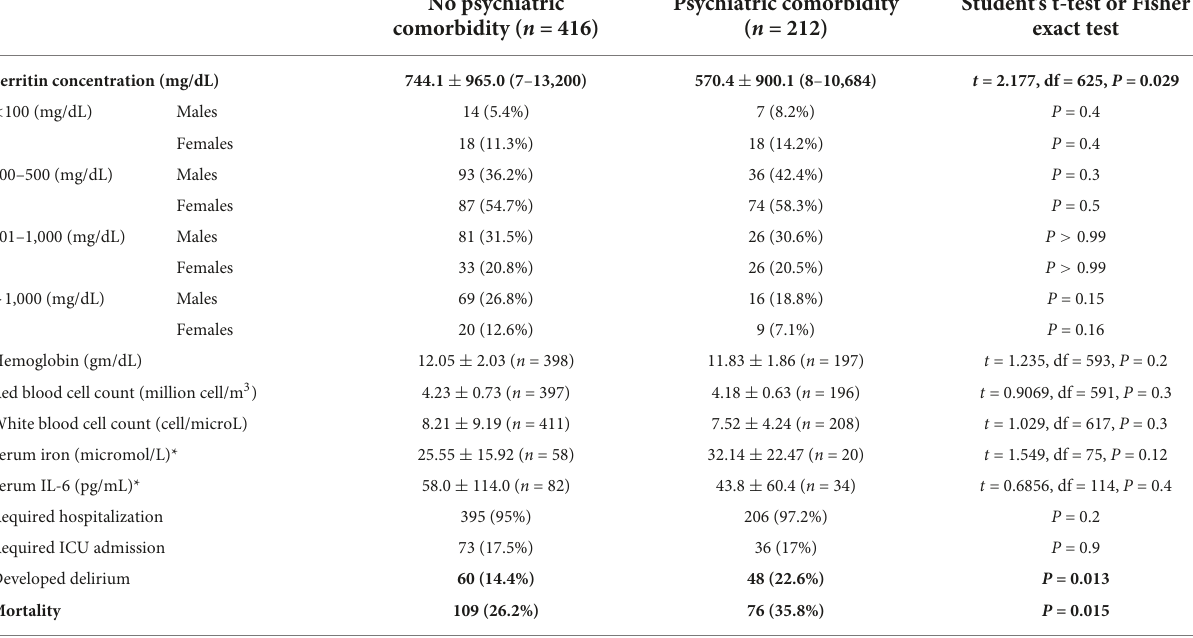
TABLE 3 Ferritin concentration, hemoglobin, red and white cell counts, serum iron, interleukin 6 (IL-6) concentrations and hospitalization, ICU admission, delirium, and